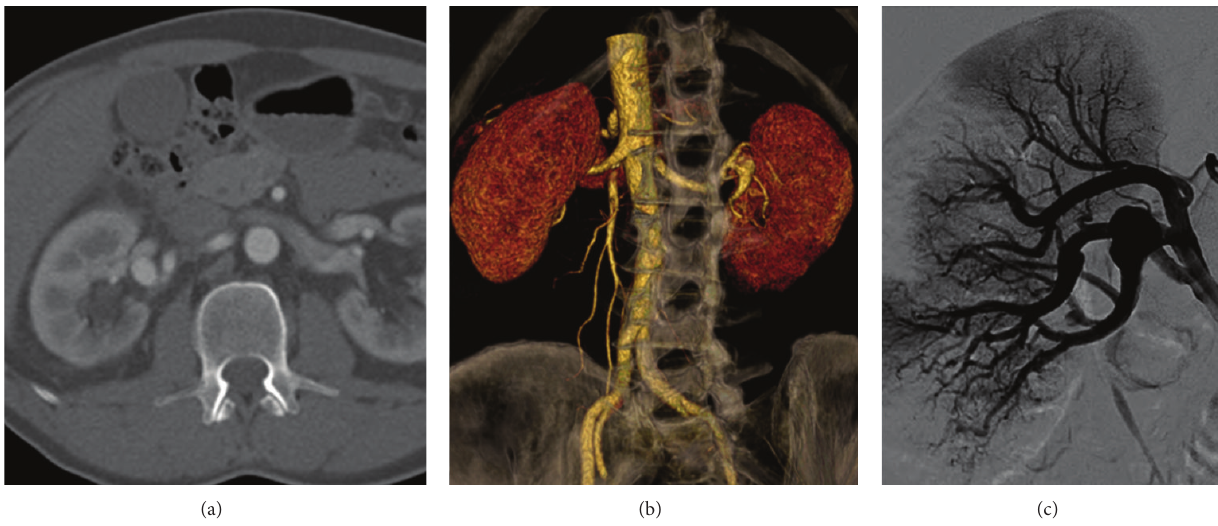
Figure 1: Preoperative 3D volume rendering computed tomography scan (a), with volume rendering 3D reconstruction (b) and angiography (c) showing the 20 mm fusiform aneurysm ( arrows, a-b-c) of the secondary inferior branch of the right renal